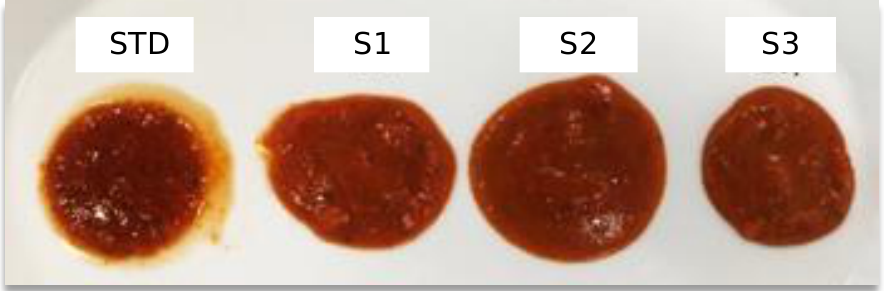
Figure 7. Appearance of tomato sauce ( STD ) and tomato sauce samples at increasing M 2 level ( S1 – S3 ). For the meat patty, a significant increase of the cooking yield (CY) was observed for S2 and S3